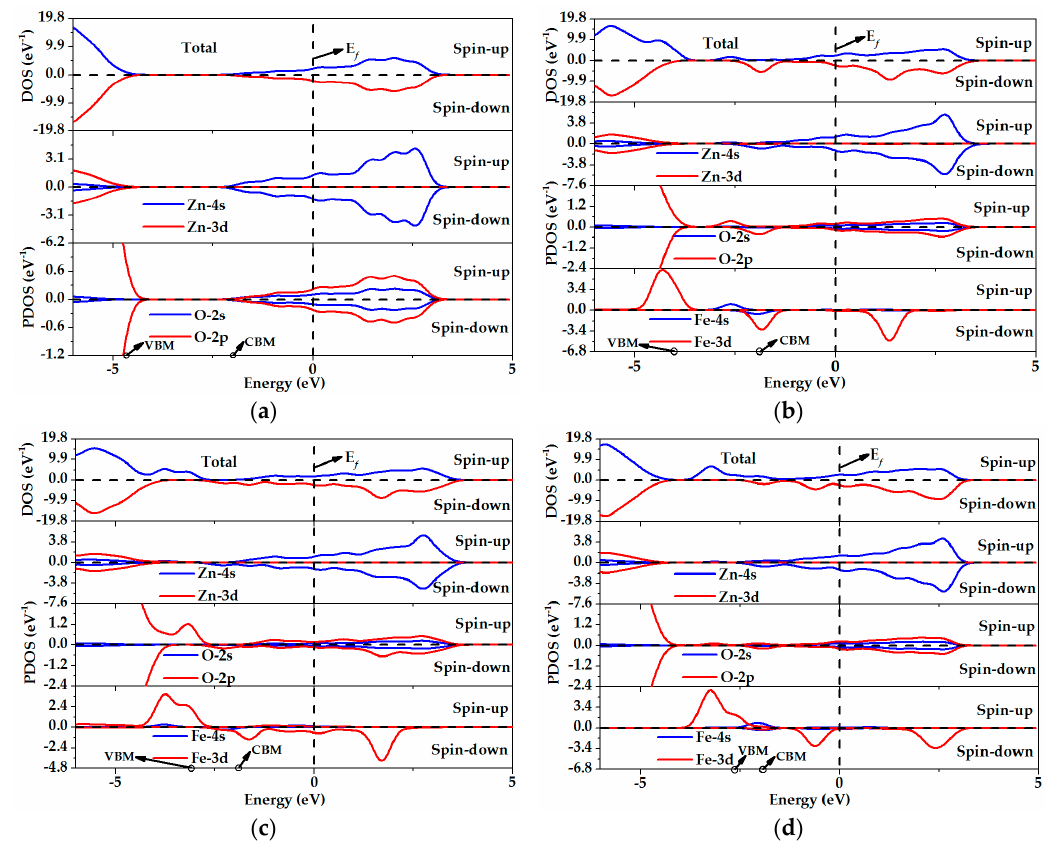
Figure 5. The total density of state (TDOS) and the projected density of state (PDOS) of ( a ) the pristine ZnO (0001) and the iron atom adsorbed on ( b ) the H 3 site, ( c ) the T 4 site, and ( d ) the Top site of ZnO (0001) surface via the GGA+U method. The positions of the conduction band minimum (CBM) and the valence band maximum (VBM) are also denoted.